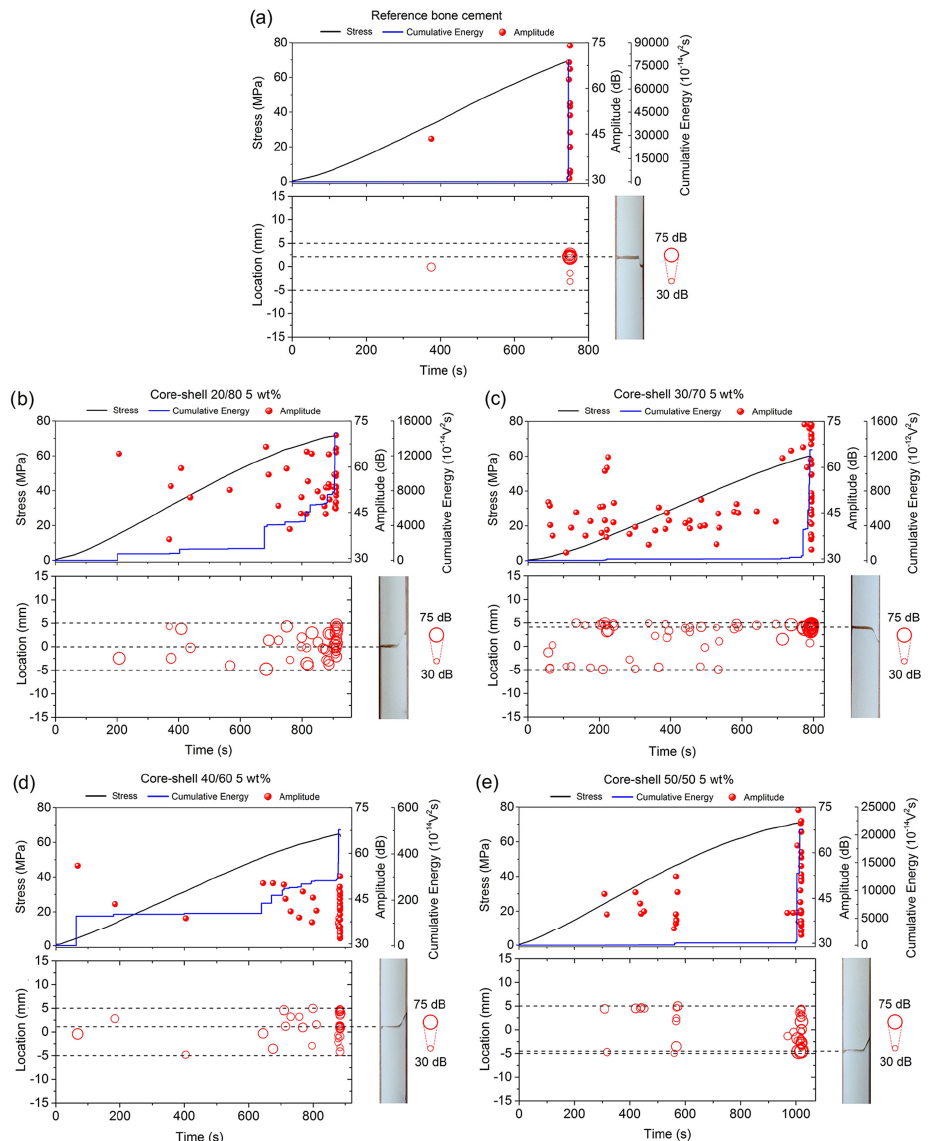
Figure 4. AE signals detected during the four-point bending test in correlation to their respective locations along the specimen surface in ( a ) the reference bone cement and bone cements containing 5 wt % of core-shell nanoparticles ( b ) 20 / 80, ( c ) 30 / 70, ( d ) 40 / 60, and ( e ) 50 /